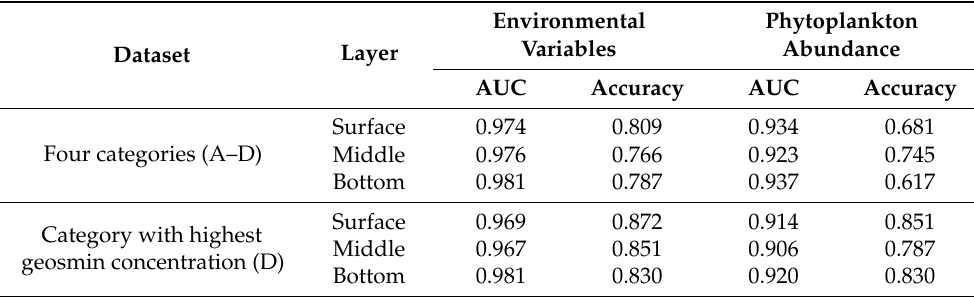
Table 5. Prediction accuracy of geosmin concentration in three different water layers using random forest model. Categories (A–D) of geosmin concentration are given in Table